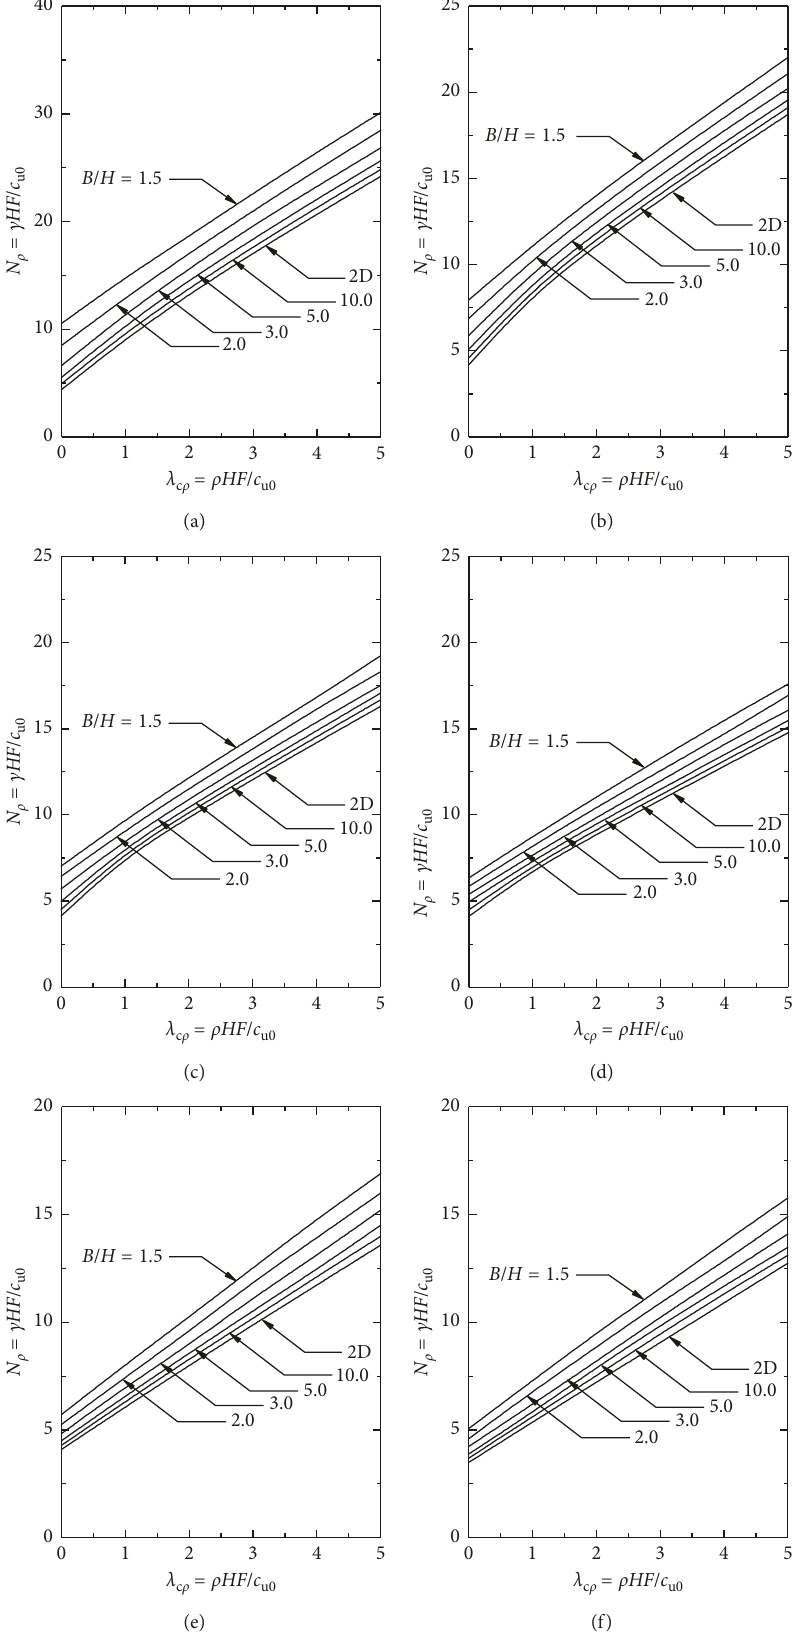
Figure 10: Seismic stability charts for natural slopes with k